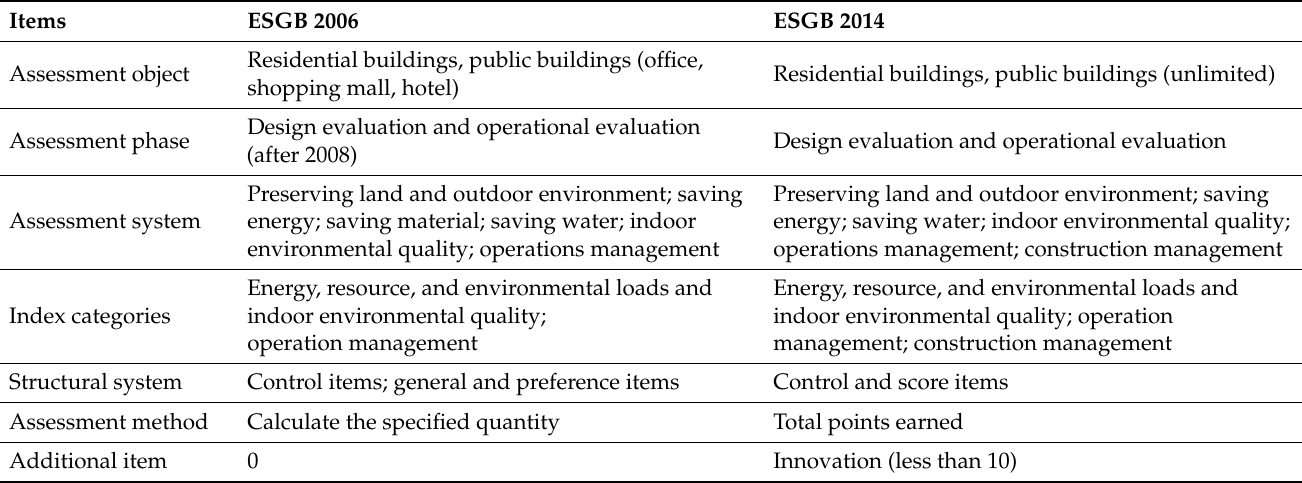
Table 3. Comparison between ESGB version 2006 and version